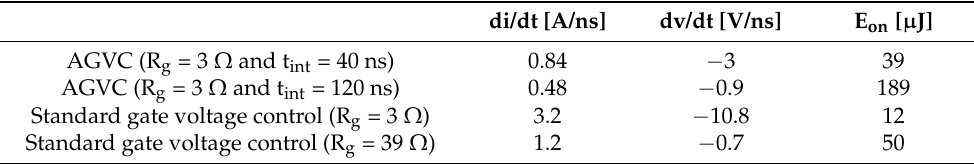
Table 2. Comparison of energy losses using AGCV and standard gate control with load current without saturation (I d = 28